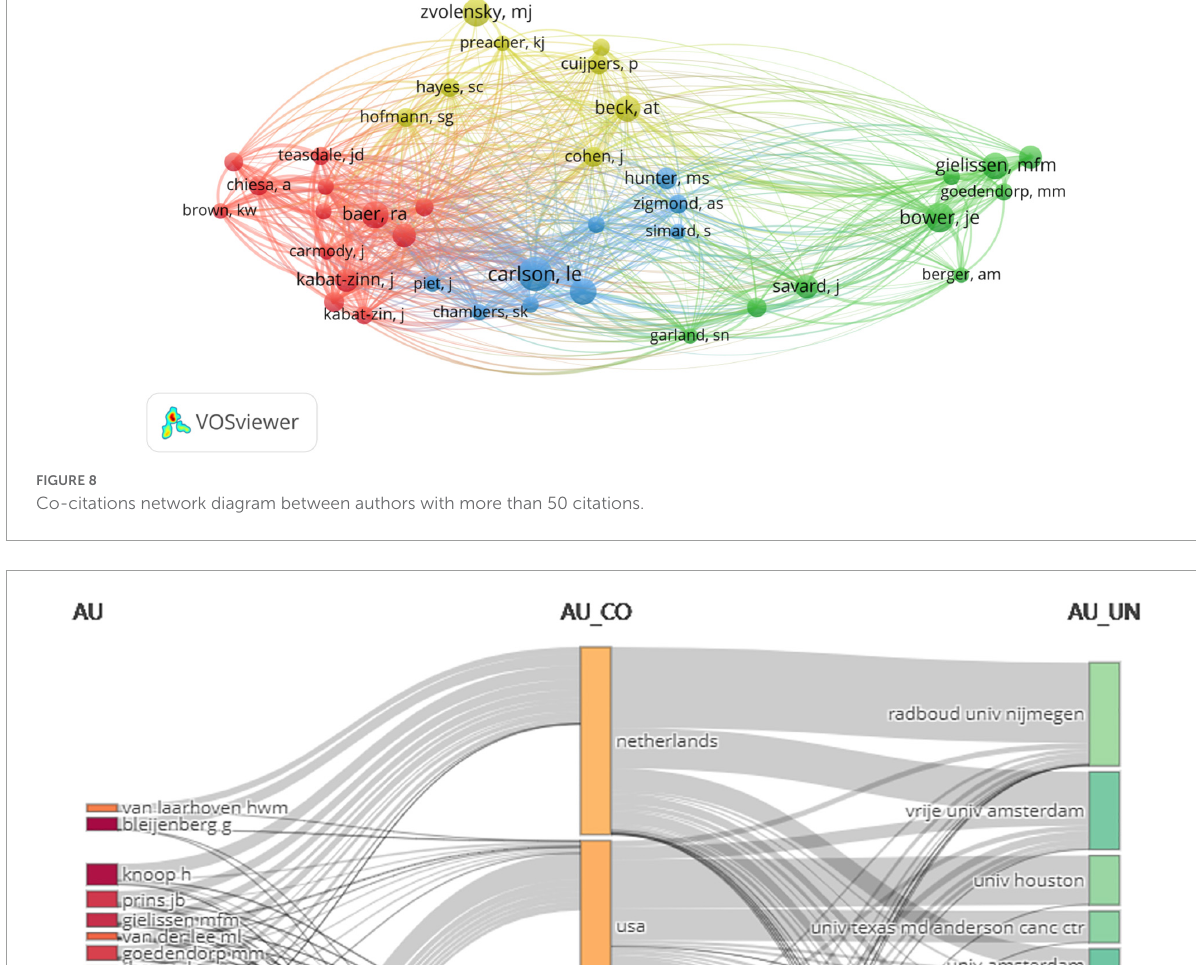
therapy,” “Survivors,” “Women”), and pink cluster (“Cognitive therapy,” “Meditation,” “Mental-health”), had a strong link to the researches but were poorly developed. In addition, both the green and orange clusters were close to the center,